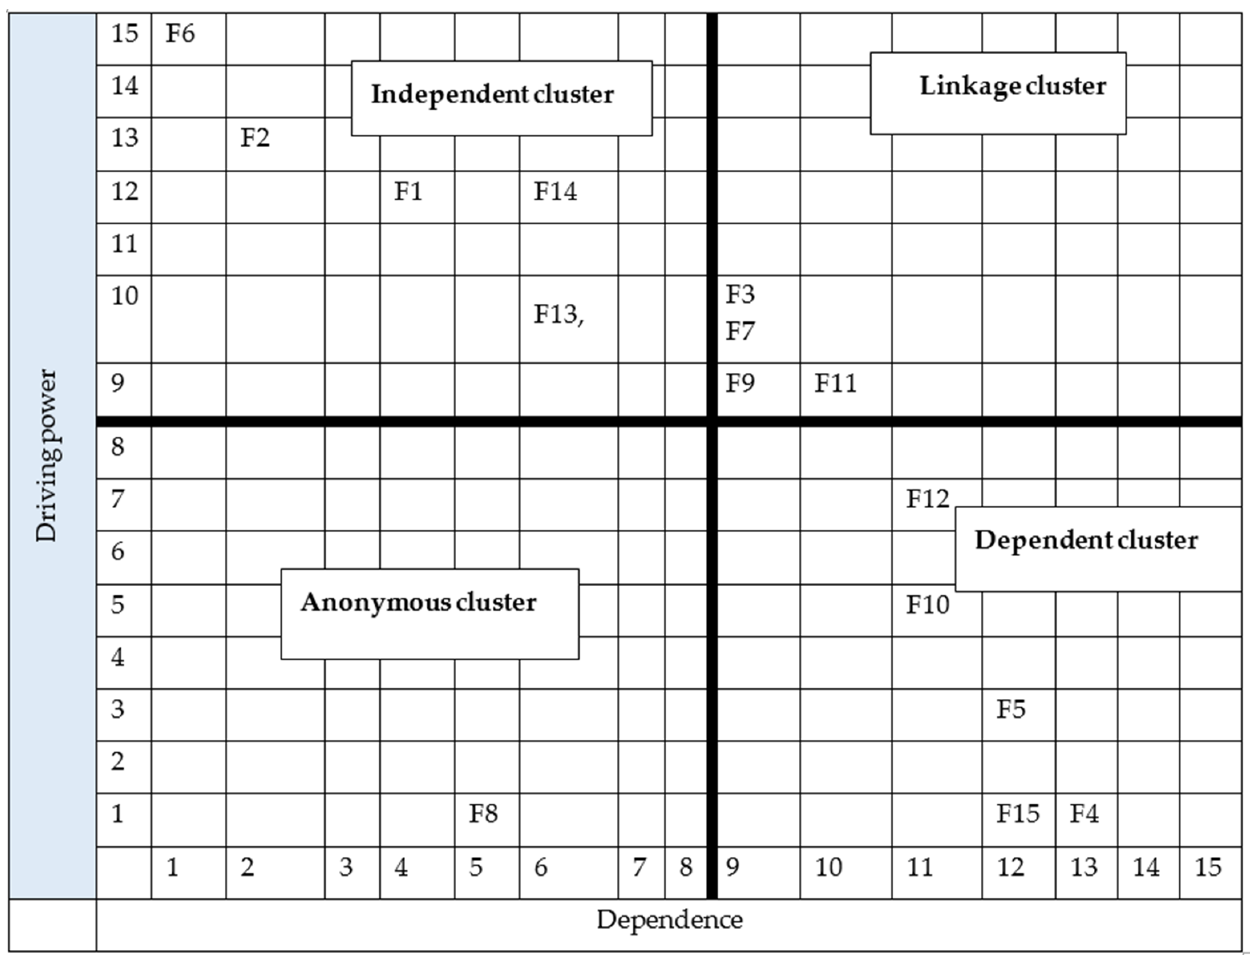
Figure 3. Classification of BIMfD implementation factors.